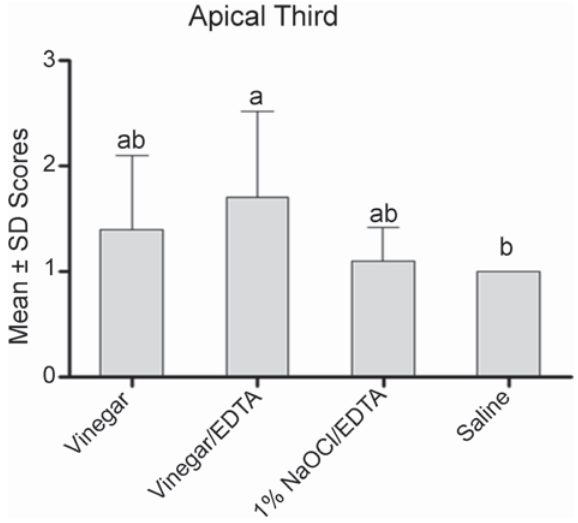
Figure 5- Mean scores±Standard deviation recorded for each group (n=10) in the apical root third. The groups with a different superscript letter are statistically different (p<0.05) The B group produced significantly cleaner canals in both middle and apical thirds (p=0.0402 and p=0.0373, respectively). The sequence of